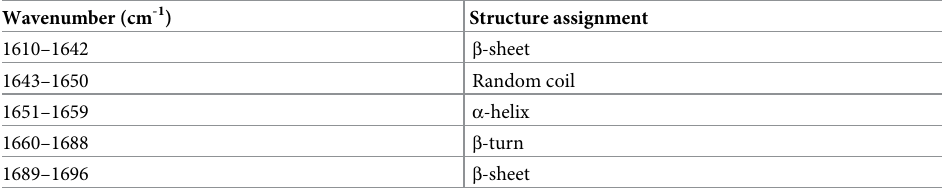
Table 2. FTIR secondary structure